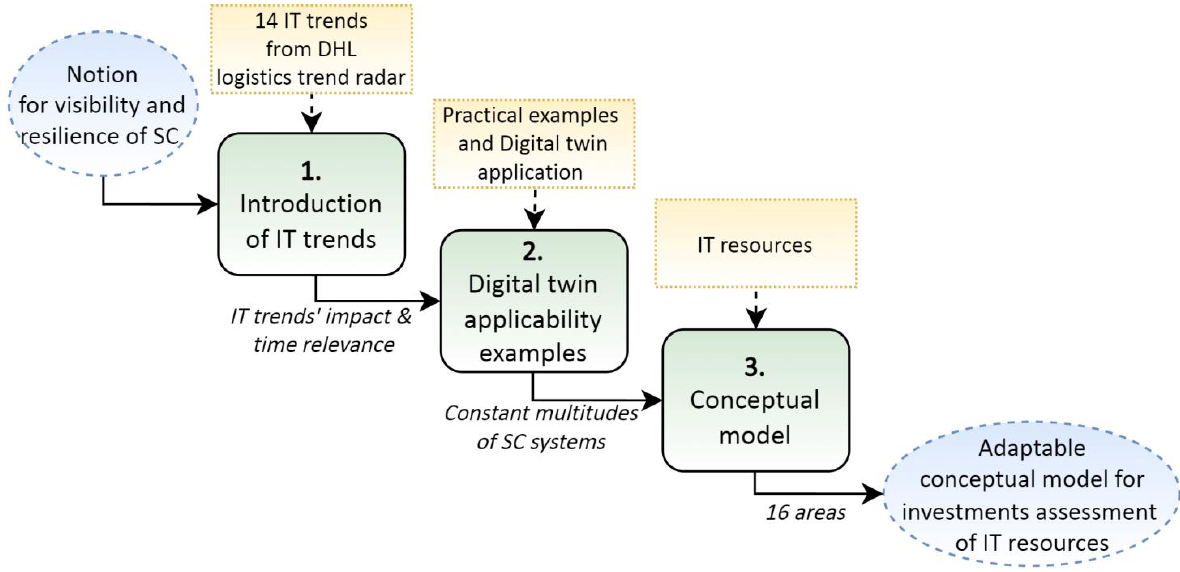
Figure 1. Research methodology process — stages of conceptual model development.